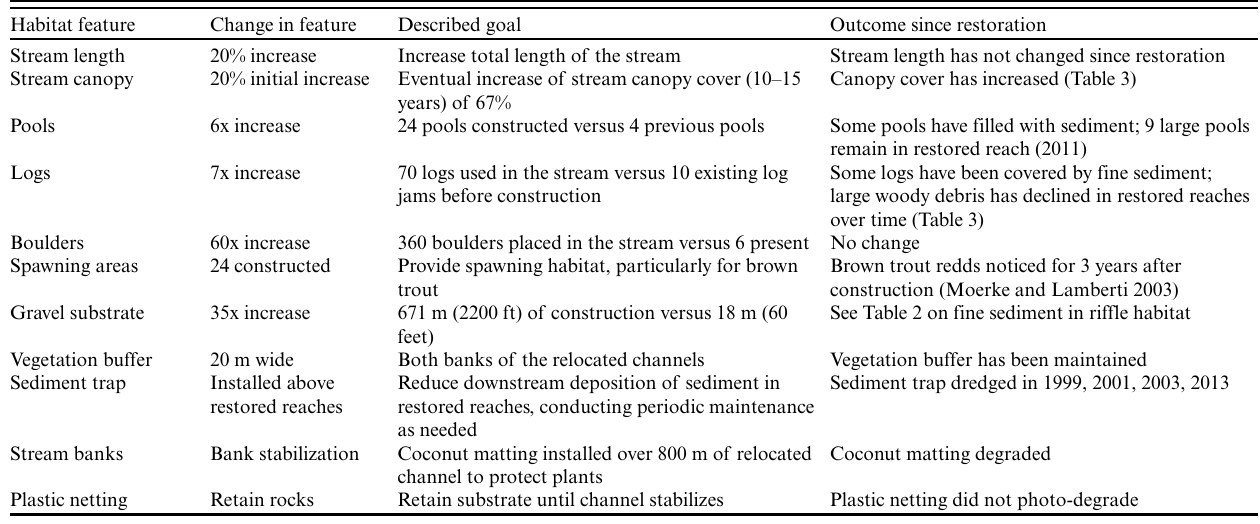
Table 1 . Design and outcome of the restoration project constructed by relocating two reaches of Juday Creek at the Warren Golf Course at the University of Notre Dame,